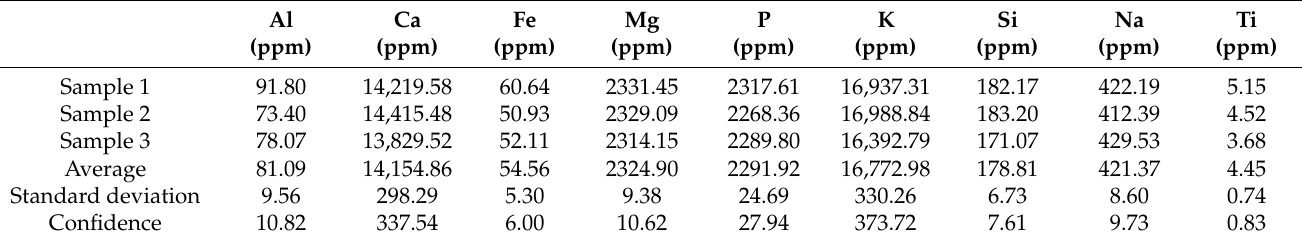
Table 8. Determination of the content of major elements of carbonized samples.